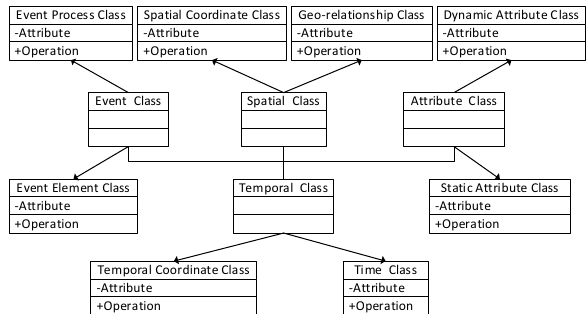
Figure 5. Logical Structure Diagram of Multidimensional Feature